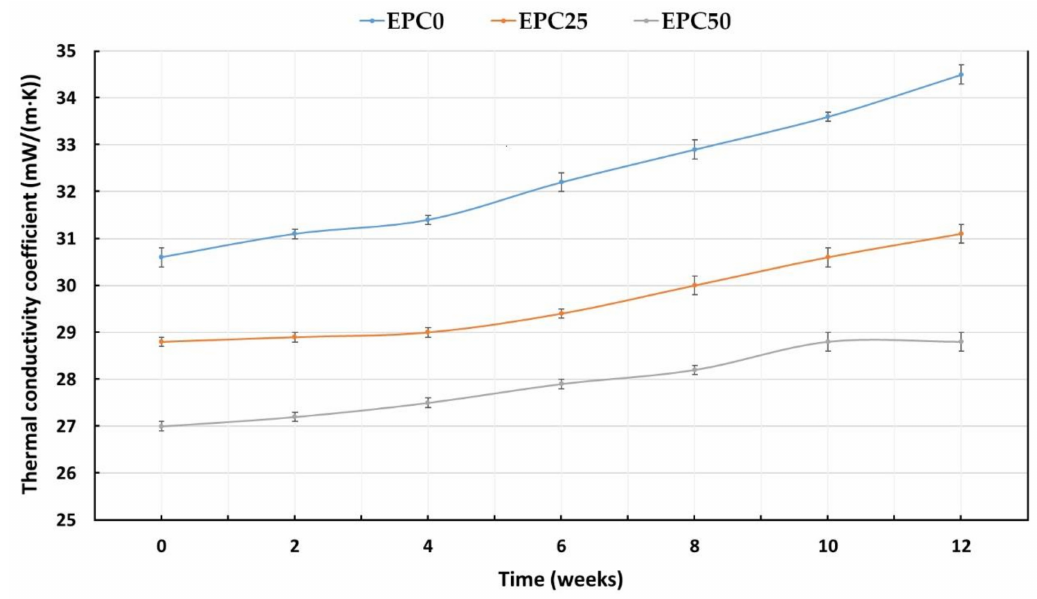
Figure 2. Changes in the value of the thermal conductivity coefficient of selected foams during the aging process at room temperature.